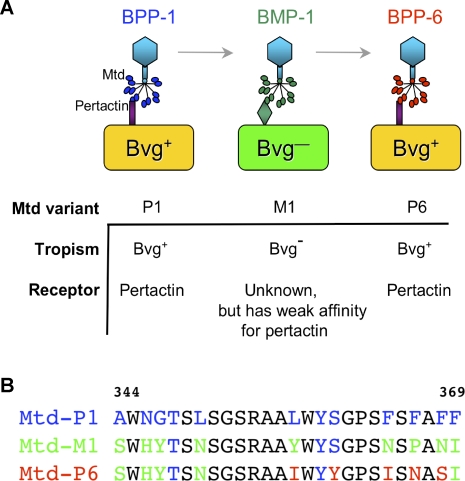
Tropism and Receptor Specificities of Bordetella Bacteriophages(A) The Mtd-P1 variant is expressed by BPP-1 phage and sets the tropism of the phage to Bvg+
Bordetella due to recognition of the Bvg+-specific receptor pertactin. The Mtd-M1 variant is a direct descendant of Mtd-P1 and is expressed by BMP-1 phage. It sets tropism to Bvg–
Bordetella through recognition of an unidentified receptor. Mtd-M1 also binds pertactin, albeit nonproductively. The Mtd-P6 variant is a direct descendant of Mtd-M1 and is expressed by BPP-6 phage. It sets the tropism of BPP-6 to Bvg+
Bordetella due to recognition of pertactin.(B) Variable region sequences of Mtd-P1, Mtd-M1, and Mtd-P6. Variable residues are in color, and invariant residues in black. For Mtd-P1, variable residues are in blue. For Mtd-M1, variable residues in common with Mtd-P1 are in blue, and those unique to Mtd-M1 are in green. For Mtd-P6, residues in common with Mtd-M1 or Mtd-P1 are in green or blue, respectively, and those unique to Mtd-P6 are in red. Mtd has 381 residues in total.